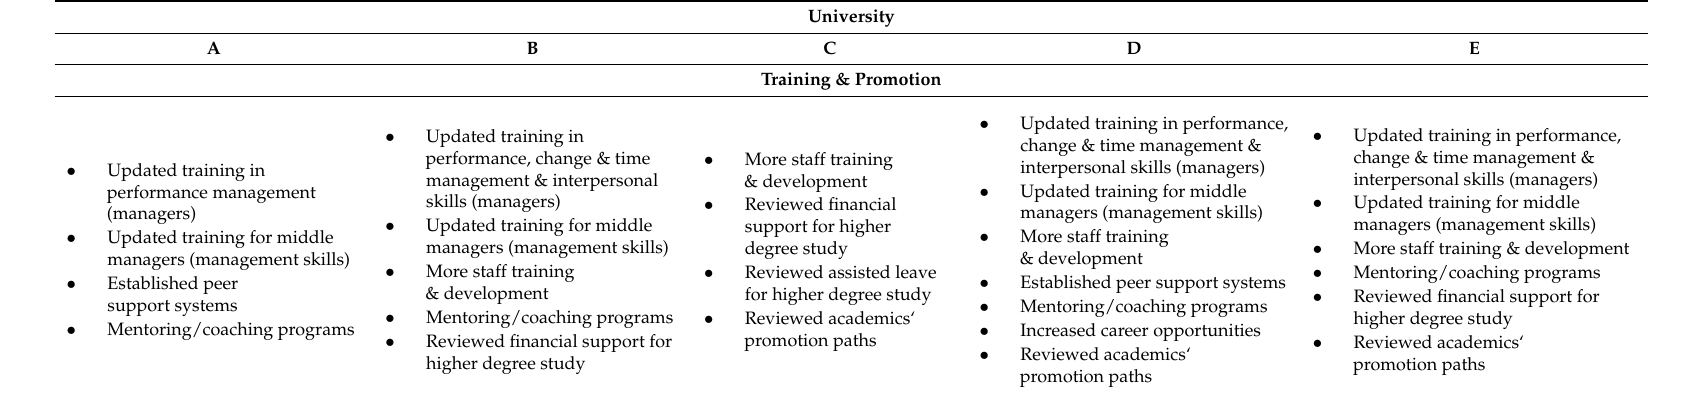
Table 6. Interventions to Enhance Training and Promotional